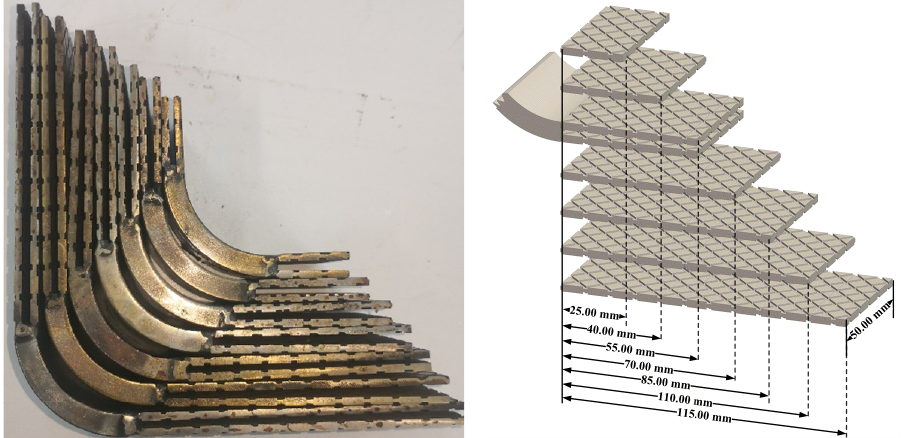
Figure 3. Groove structure with different bonding lengths.